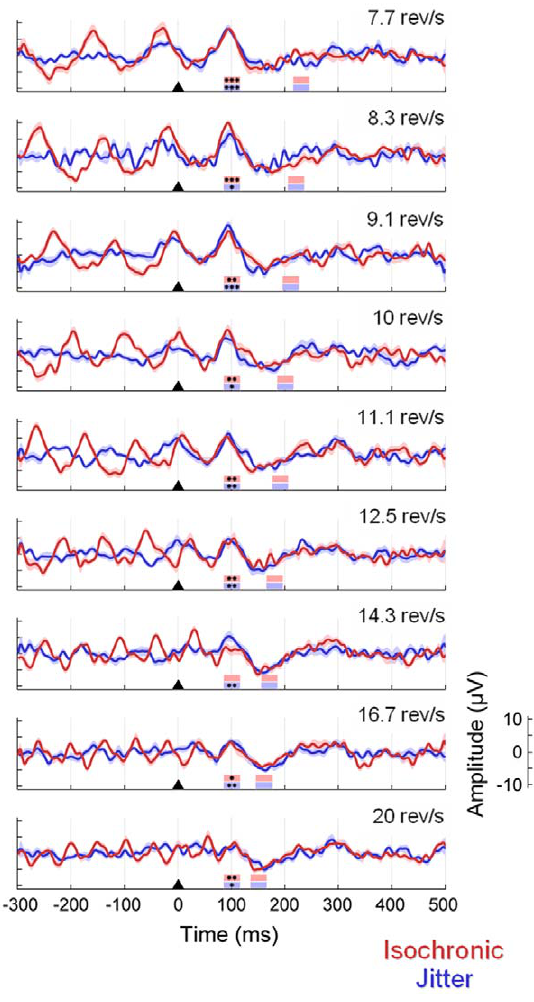
Figure 11. Absence of additional activity beyond the last stimulus of the sequence. The figure shows the grand-average ERPs time-locked to the last stimulus of the train for both isochronic (red lines) and jitter (blue lines) conditions from Experiment 2. The shaded area represents the standard error of the mean across subjects. Triangles indicate the onset of the last stimulus. The time window corresponding to the P100 component has been marked by the first column of coloured boxes (from 85 to 110 ms after stimulus onset; red: isochronic conditions; blue: jitter conditions). The time window corresponding to a potential additional response has been marked by the second column of coloured boxes, with different latency depending on stimulation rate. The asterisks indicate average responses signifi- cantly higher than 0 (*p , .05; **p , .01; ***p , .001); whereas the absence of asterisks indicates no significant responses (p . discussed in the paragraph above.